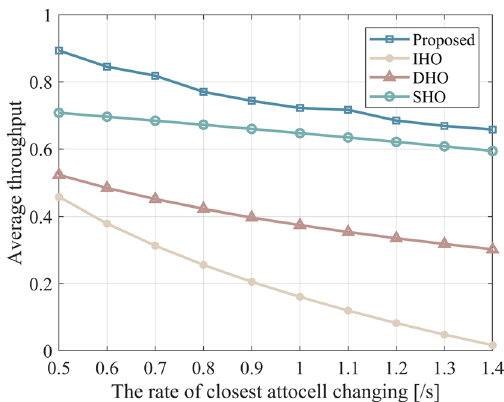
Fig. 8 The normalized average throughput of UD versus the rate of closest attocell changing. Figure illustrates the relationship of average throughput with the rate of closest attocell changing. Yellow, red, green and blue lines represent the manifestation of the immediate handover, the dwell handover, the handover skipping and we proposed handover